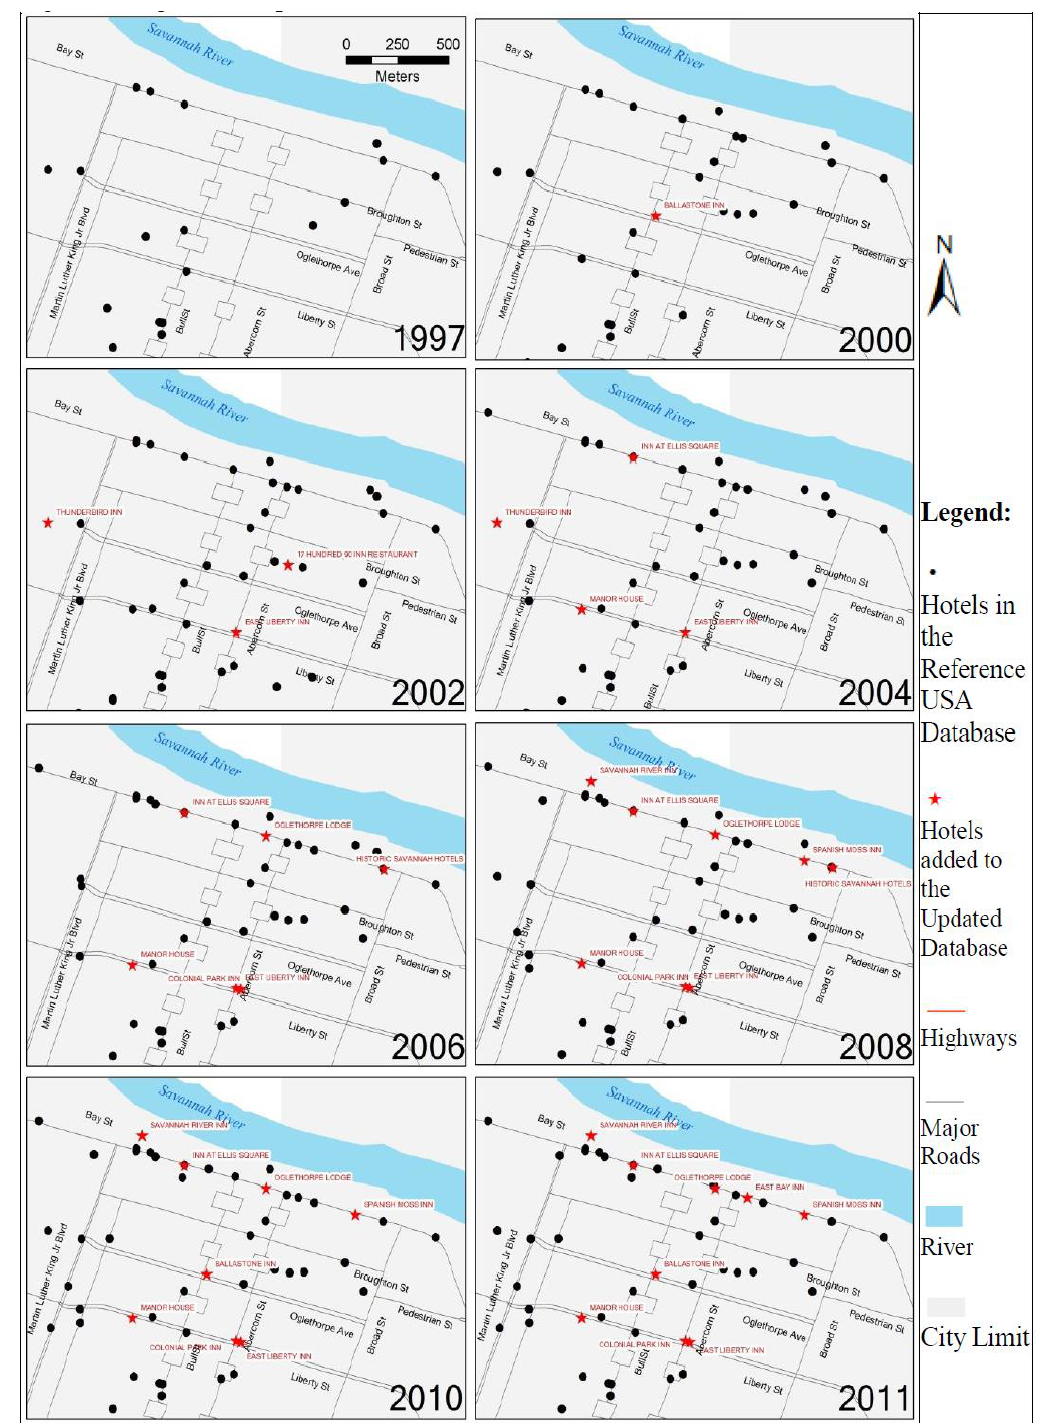
Figure 3. Original and updated hotels: Savannah, GA, USA.